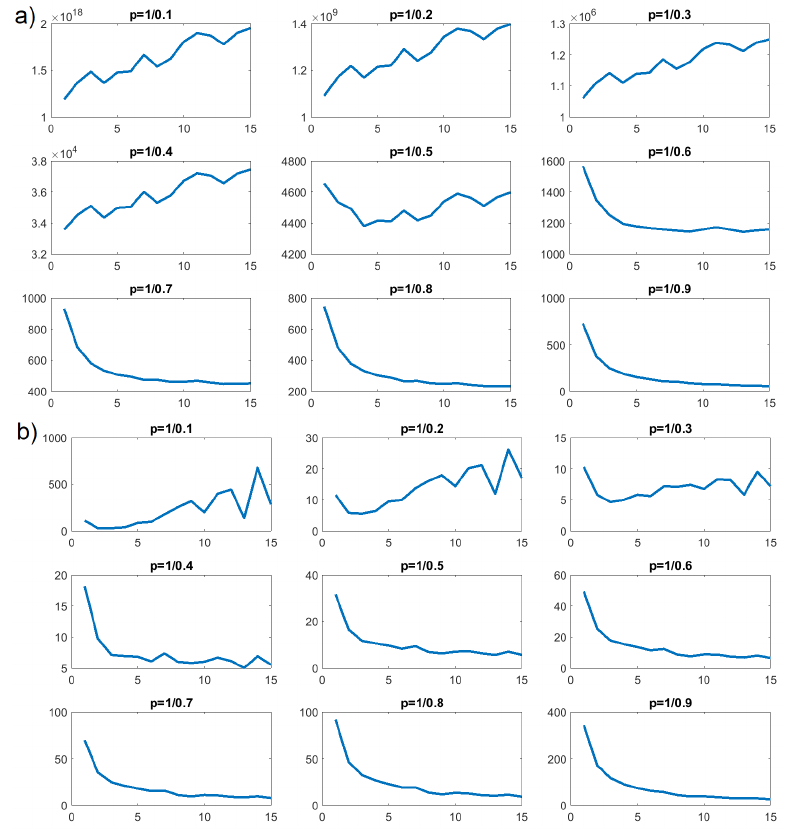
Figure 12. p -variation as a function of n for HBO in concentration c 2 : ( a ) intermolecular; ( b )